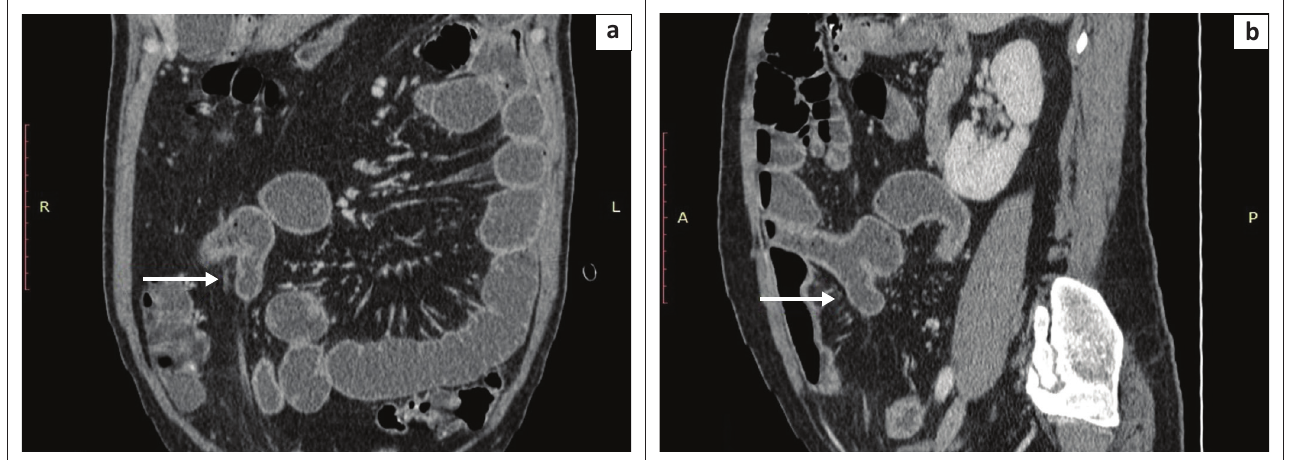
FIGURE 1: Contrast enhanced computed tomography in the coronal (a) and sagittal (b) planes demonstrating a tubular, blind-ending structure arising from antimesenteric border of the distal ileum with enhancing walls, suggestive of Meckel’s diverticulum (white arrows). No abnormal wall thickening or surrounding fat inflammation was present.